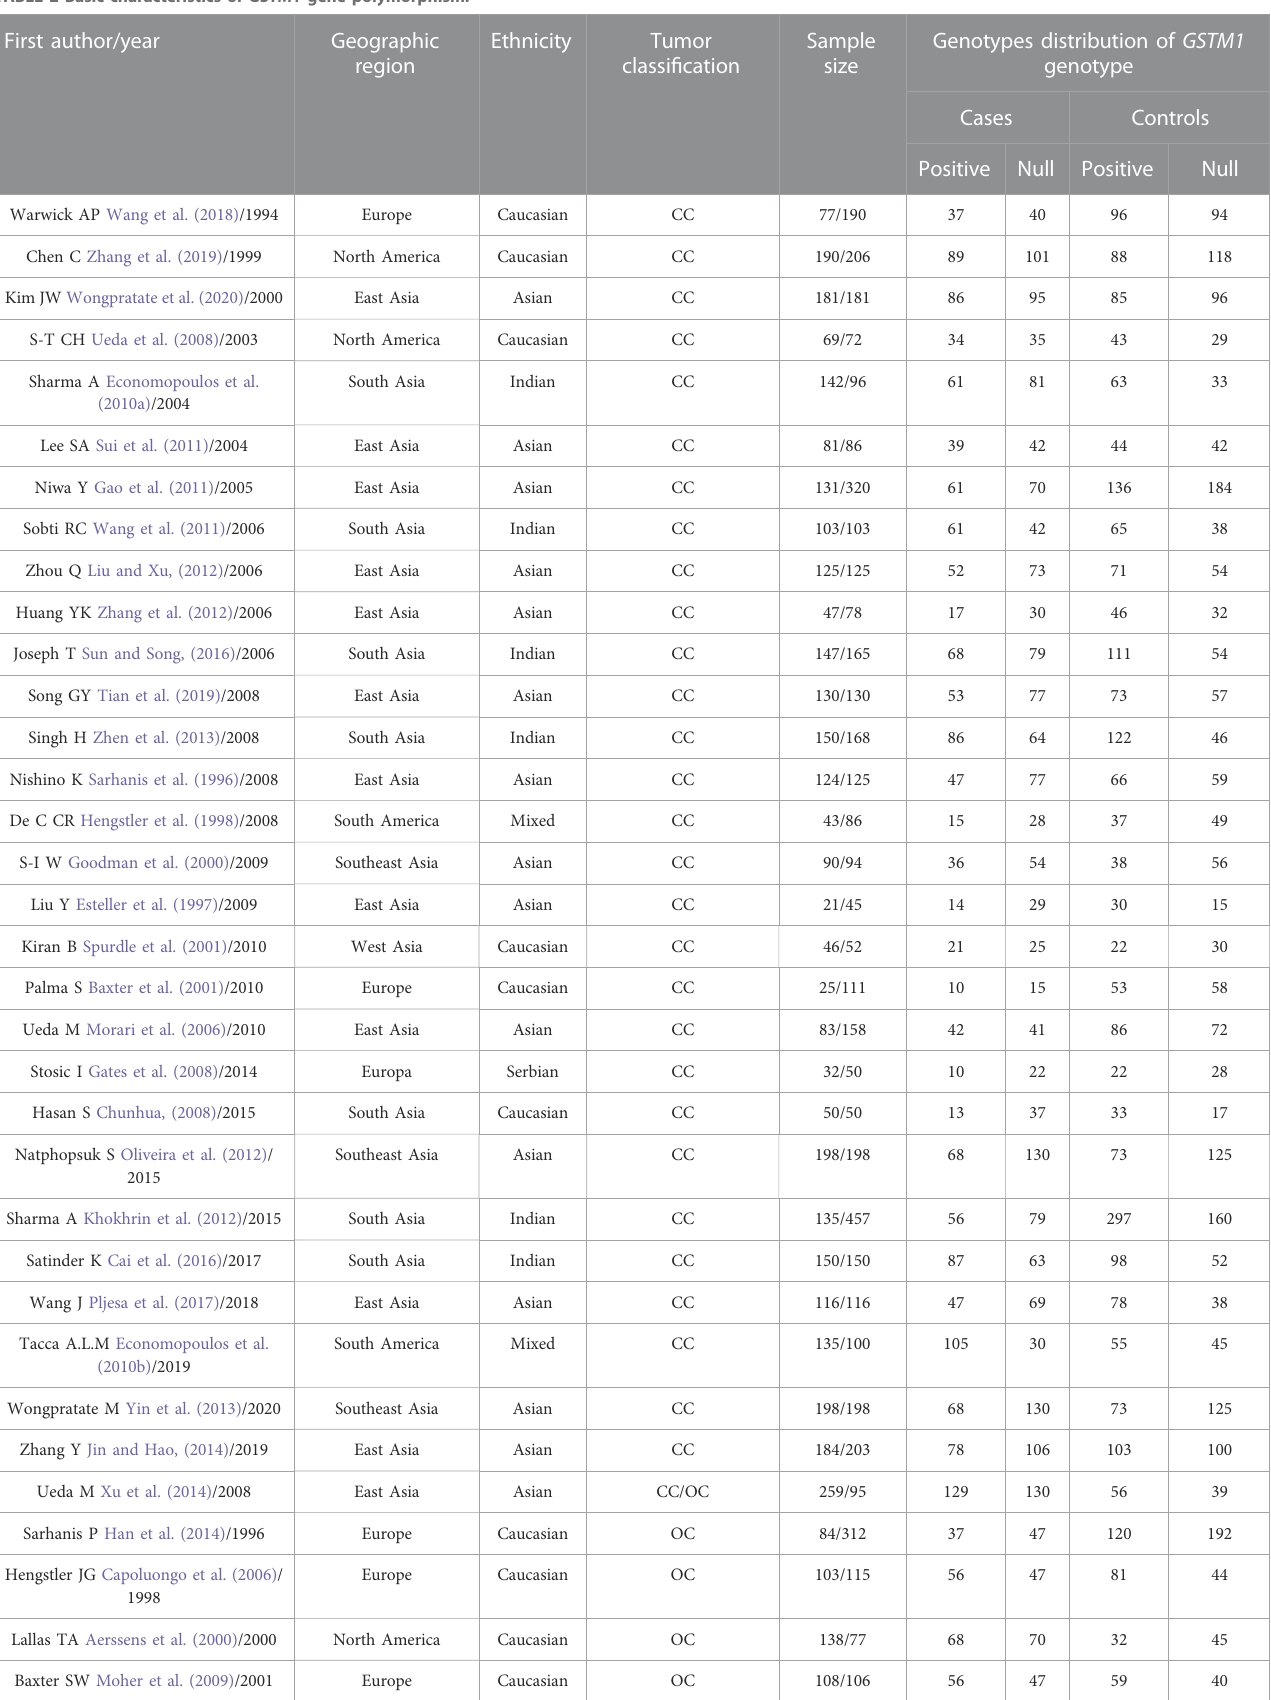
TABLE 2 Basic characteristics of GSTM1 gene